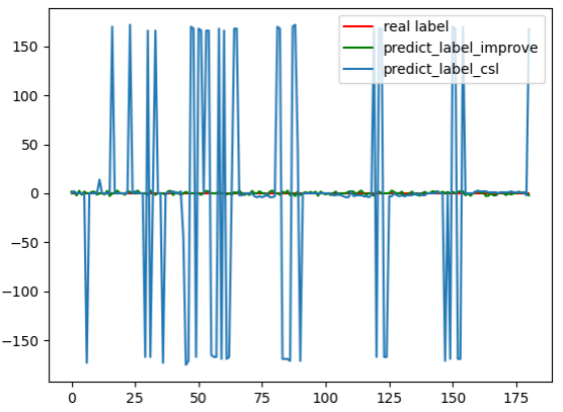
Figure 6. Annotation and prediction angle fitting